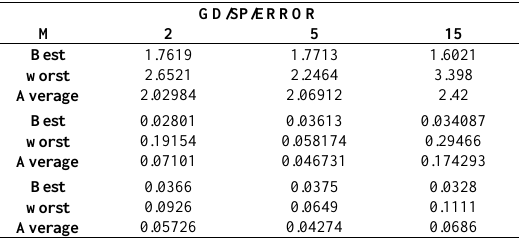
Table 6. GD/SP/ERROR analysis on second test